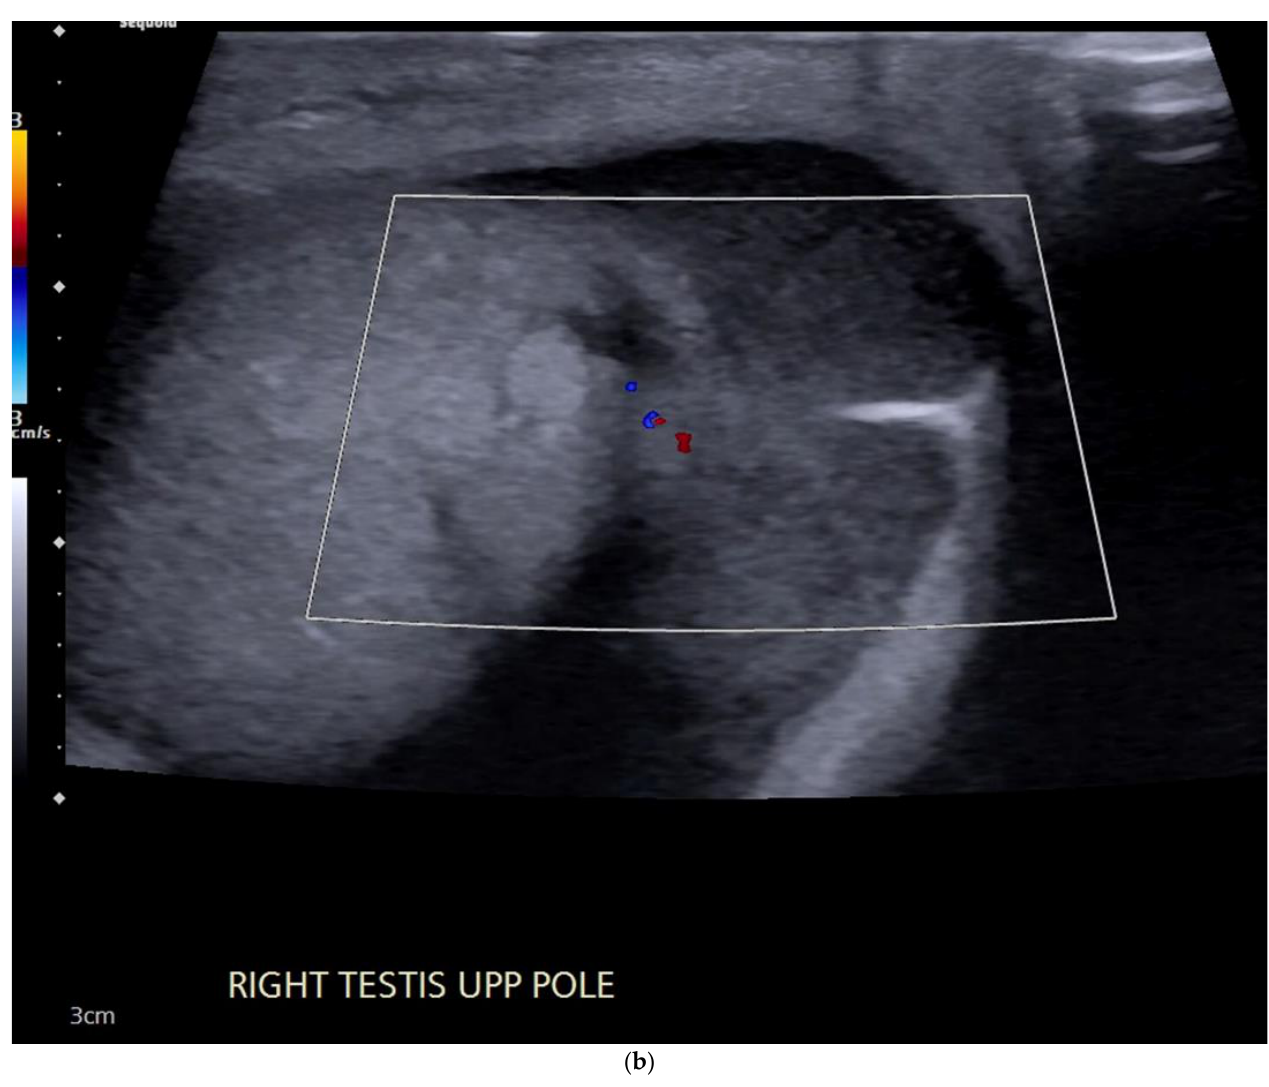
Figure 7. ( a ) Well-defined hyperechoic lesion in the right testis measuring < 5mm in all dimensions. ( b ) The lesion is confirmed to be avascular. Previous ultrasound two years earlier showed that the lesion was unchanged in size and appearance.